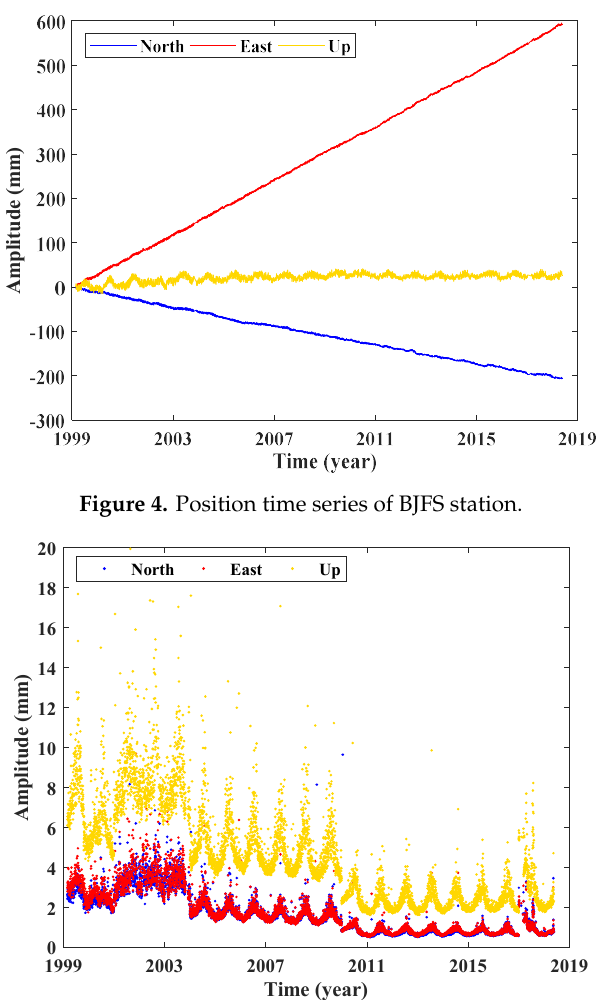
Figure 5. Formal errors of BJFS station.